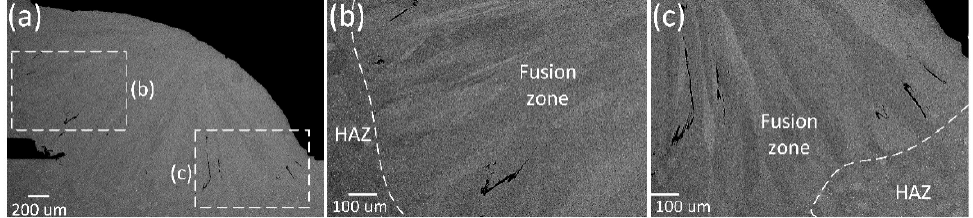
Figure 7. ( a ) SEM images taken in the weld zone of S2-F50 at P B = 3.25 kW showing representative view of micro cracks. ( b , c ) show detailed distribution of micro cracks along the grain boundaries of columnar grains.